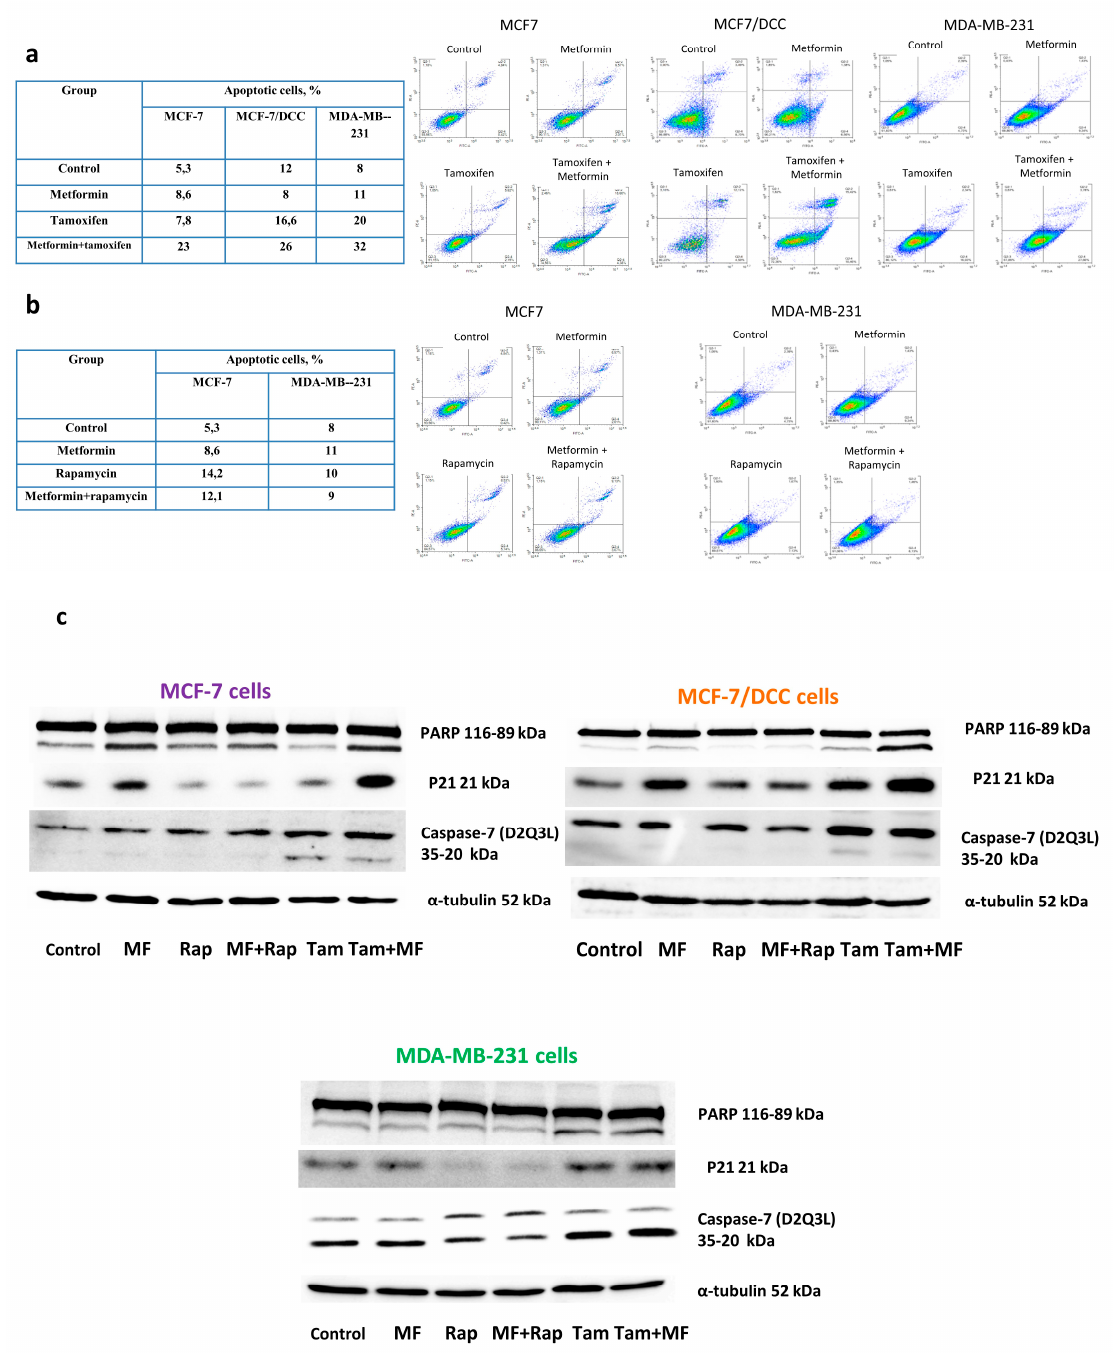
Figure 8. Tamoxifen and apoptotic cell death. The MCF-7, MCF-7 / DCC, and MDA-MB-231 cells were treated with 1 µ M rapamycin or 5 µ M tamoxifen in the presence or absence of 2 mM metformin. Apoptosis was quantified via combined staining of annexin V and propidium iodide ( a , b ) as described in Methods (CV < 5%). Western blot analysis of PARP, p21 / Waf, and caspase-7 was performed in the cell extracts. Caspase-7 (D2Q3L) antibody detects both the full-length (35 kDa—upper bands) and large (20 kDa—lower bands) subunits following caspase-7 activation. Protein loading was controlled by membrane hybridization with α -tubulin antibodies ( c